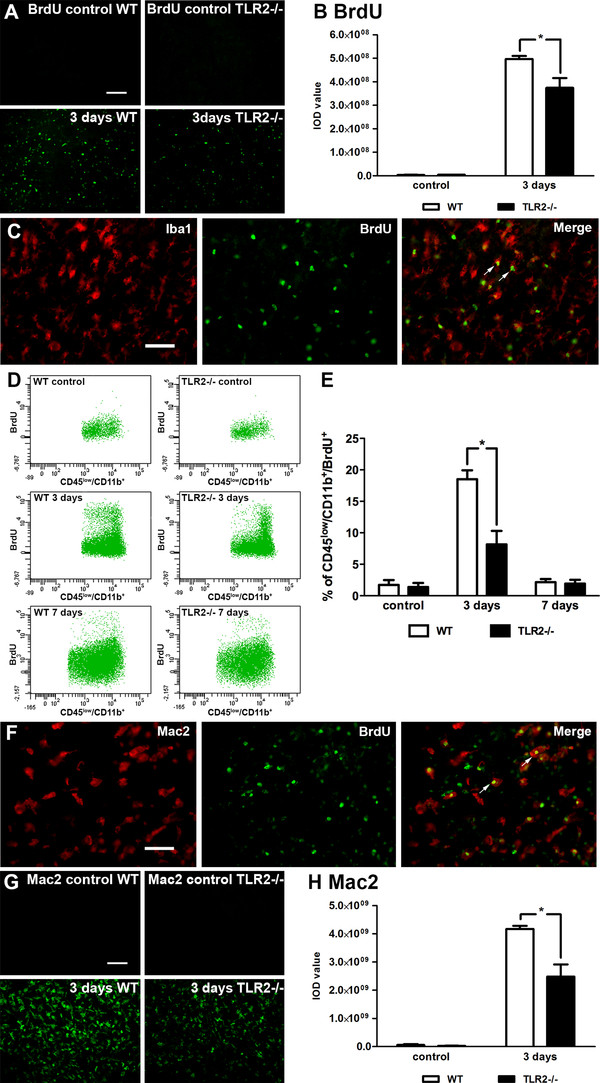
Toll-like receptor 2 deficient mice display reduced proliferation of resident microglial cells. (A) Photomicrographs of BrdU immunoreactivity in wild-type (WT) and Toll-like receptor (TLR) 2−/− mice 3 days after transient middle cerebral artery occlusion (MCAO) and their unlesioned controls, respectively. (B) Quantification of BrdU immunoreactivity indicates reduced cell proliferative capacity in TLR2−/− mice compared with WT mice 3 days after transient MCAO. (C) Representative photomicrographs of double immunostaining on WT brain sections 3 days after transient MCAO show almost complete co-localization of BrdU (green) positive cells with Iba1 (red; white arrows). (D) Flow cytometric analysis of the CD45low/CD11b+ (microglial) population proliferation in WT and TLR2−/− mice 3 days after MCAO compared with their contralateral (unlesioned) hemisphere controls. (E) Graph presents quantification of microglial proliferation measured by flow cytometric analysis. Data indicate reduced microglial proliferation in TLR2−/− mice compared with WT mice 3 days after MCAO. (F) Double immunofluorescent labeling reveals co-localization of BrdU (green) and Mac-2 (red; white arrows) in WT brain sections 3 days after transient MCAO. (G) Representative photomicrographs of Mac-2 immunofluorescence in WT and TLR2−/− mice observed 3 days after transient MCAO. (H) Quantification of Mac-2 immunoreactivity 3 days after transient MCAO revealed reduced signals in TLR2−/− mice compared with WT mice. Data (B, H) are indicated as mean ± SEM (n = 4; *P <0.05). Data (E) are expressed as percentage of CD45+ events ± SEM (n = 4; *P <0.05). Scale bars: A, G, 100 μm; C, F, 50 μm.